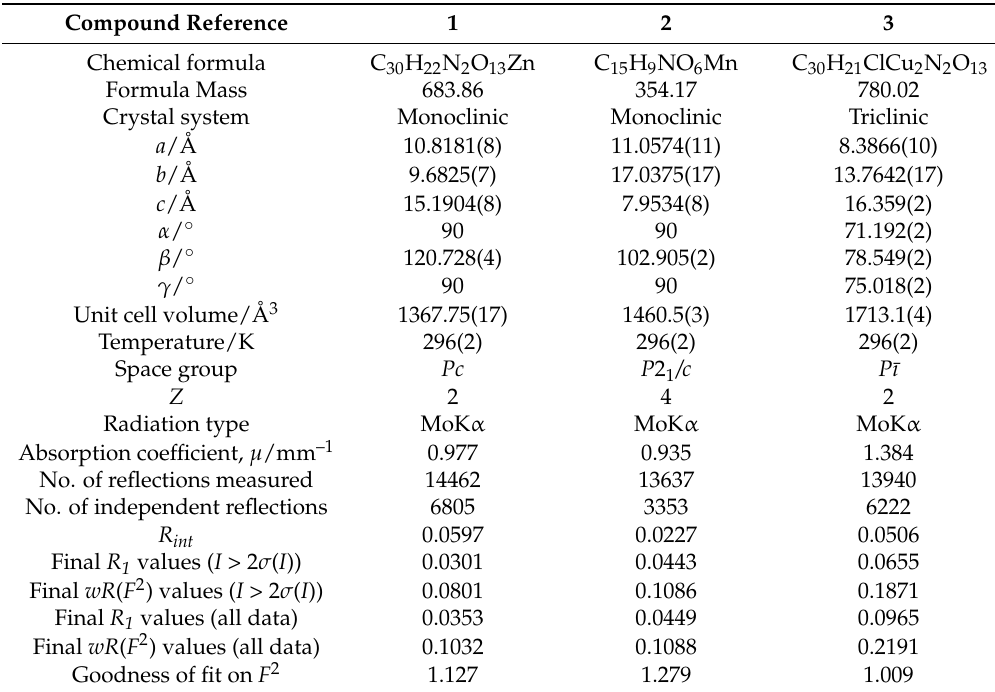
Table 1. Crystal data and structure refinement for 1 – 3 .